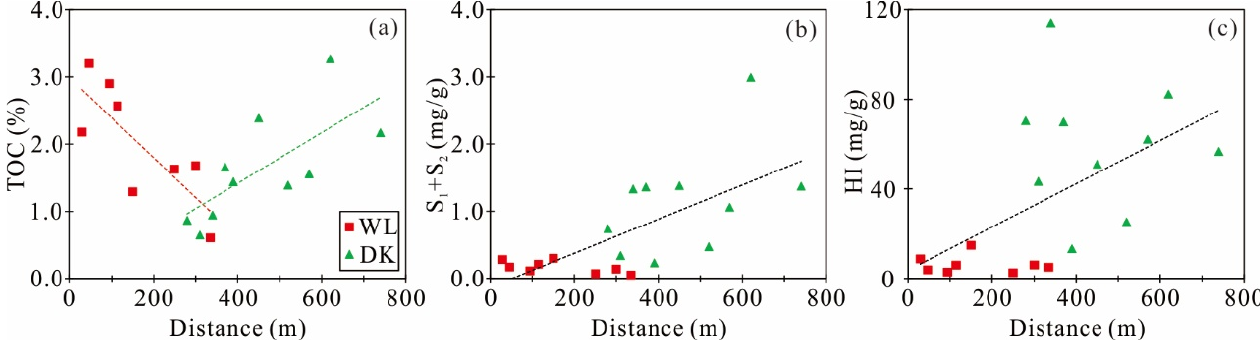
Figure 7. Cross plot of TOC ( a ), S 1 + S 2 ( b ) and HI ( c ) versus distance from the granite porphyry dike.